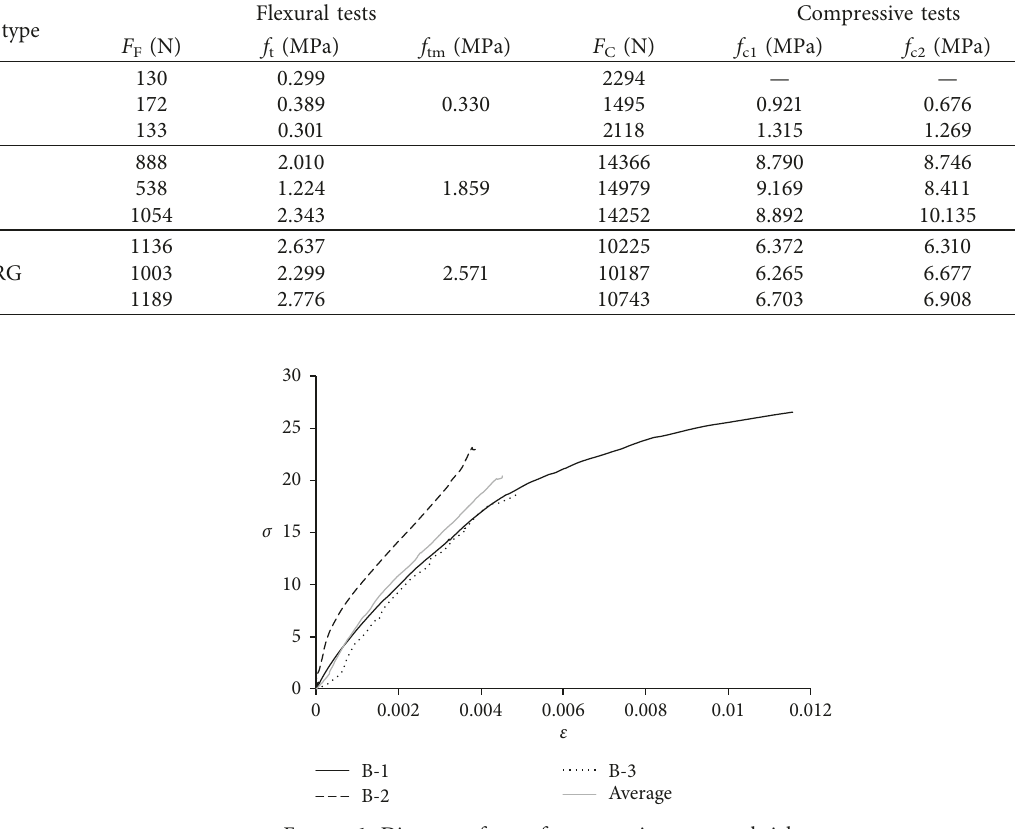
Table 1: Mechanical characteristics of mortar samples.